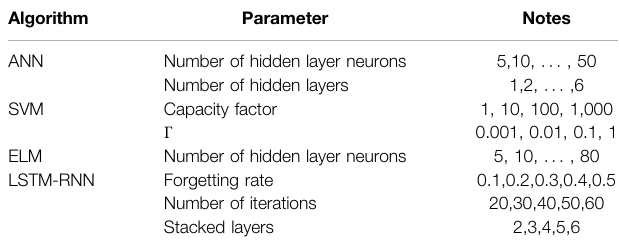
TABLE 1 | Parameter selection range in the training process of machine learning algorithms.